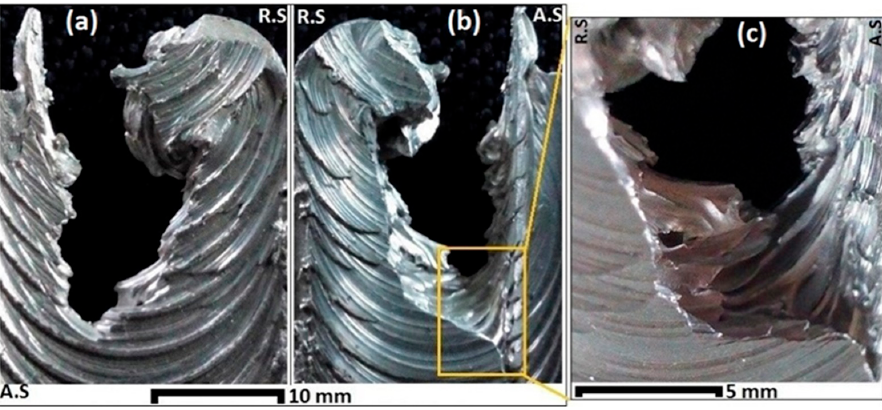
Figure 12. The exit zone for an aluminium weld: ( a ) Top view; ( b ) Bottom view; ( c ) End view.